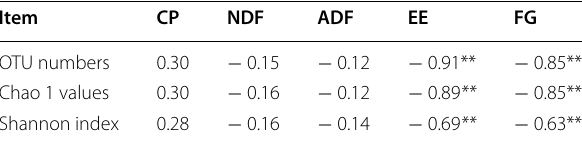
Table 2 Pearson correlation coefficients among α diversity of attached bacteria of 24 h and nutritional composition